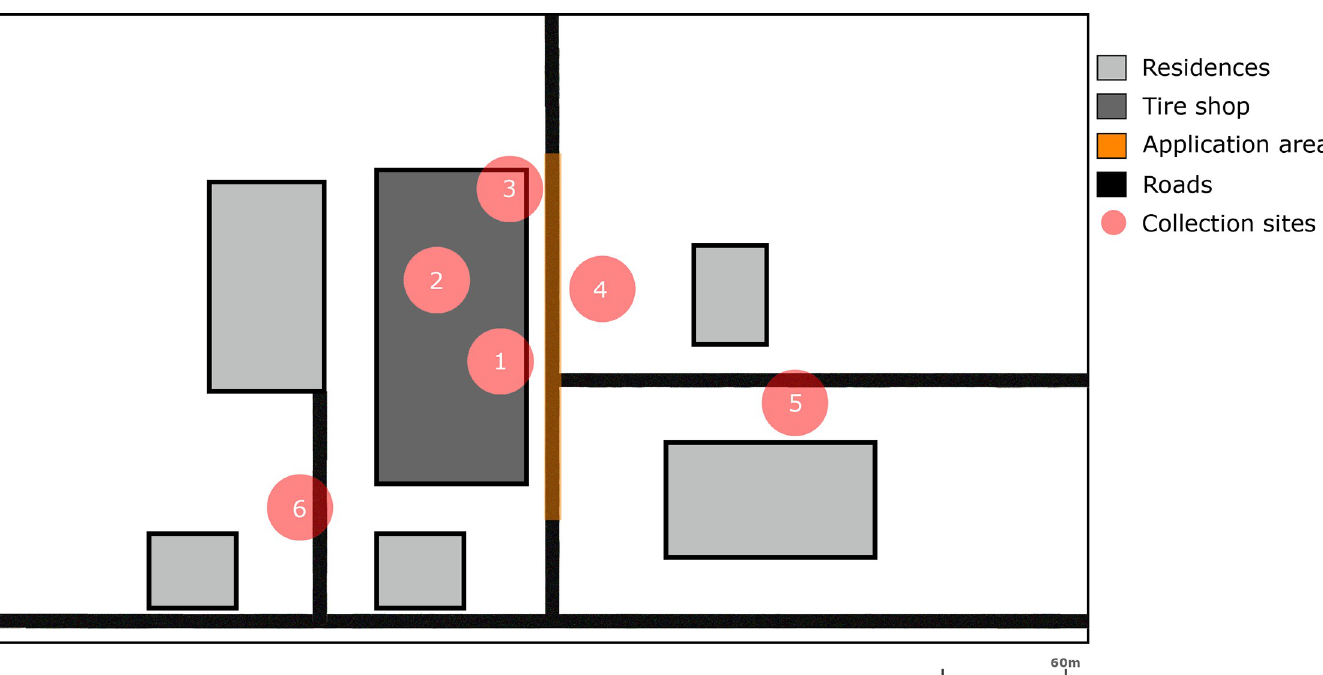
Fig 3. Map of the tire shop and surrounding area. (1) area near the office with higher flow of people; (2) virtual center of the tire shop with reduced presence of blood and sugar sources; (3) the northeastern corner of the property near vegetation; (4) bushed area across the property with many sugar sources from flowering plants and resting places; (5) abandoned railroad located at the back of the tire shop and near a bromeliad nursery with lots of vegetation; and (6) in front of a nearby residential house. The Buffalo Turbine and Grizzly ULV Sprayer spraying area is displayed in yellow.